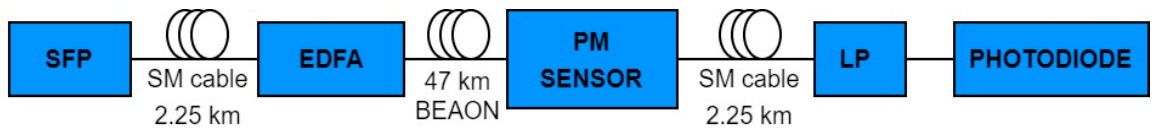
Figure 10. Simpli fi ed connection of the PM sensor measurement on the ampli fi ed optical path (EDFA). SFP—light source, EDFA—ampli fi er, LP—linear polarizer, BEAON—Brno Experimental Academic Optical Network.